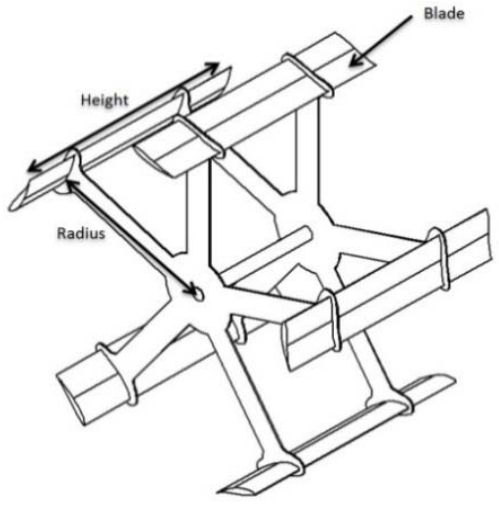
Figure 1. 3 ‐ D model of the VAWT. Figure 1. 3-D model of the VAWT.